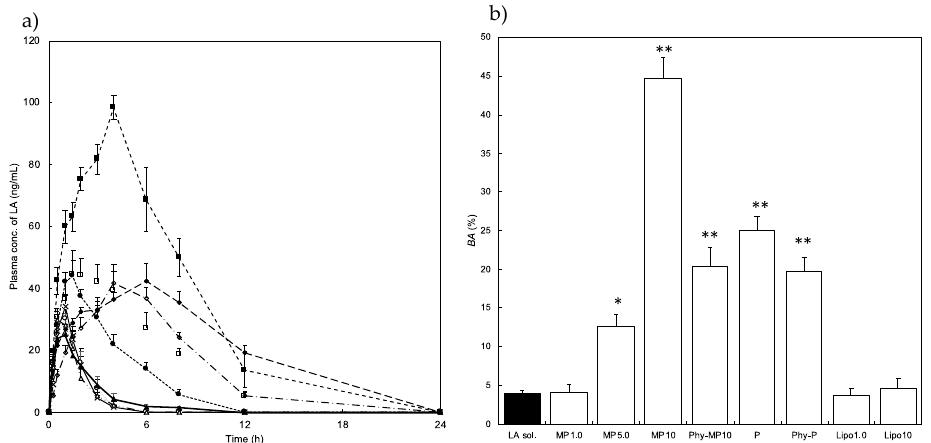
Figure 8. Plasma concentration profile ( a ) and bioavailability ( b ) of LA after subcutaneous injection of the prepared formulations. ( b ) Y-axis enlargement in ( a ). Symbols; × : LA solution, O: MP 1.0 , ♦ : Phy-P, ∆ : Lipo (cid:78) : Lipo • : MP 5.0 , (cid:4) : MP 10 , (cid:3) : Phy-MP 10 , (cid:7) : P, 1.0 , 10 . Each value shows the mean + S.E. ( n = 3). ( b ) * p < 0.05 compared with LA sol, ** p < 0.01 compared with LA Table 3. Calculated AUC after i.v. or s.c. administration of formulation. Formulation Route